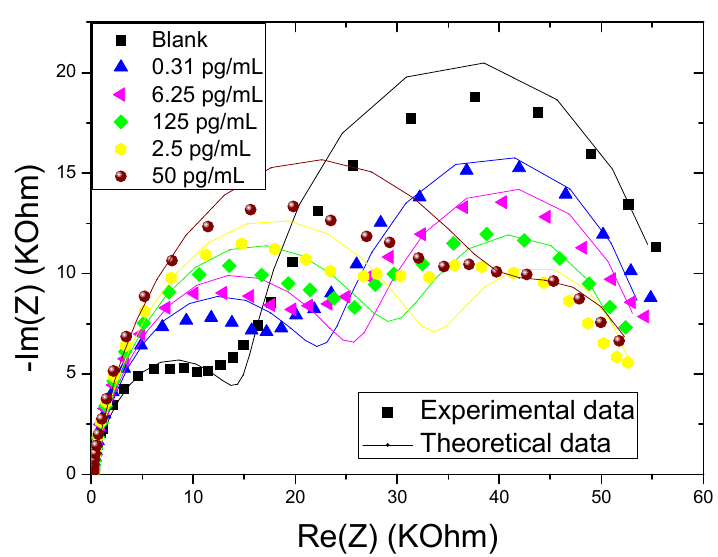
Figure 2. Experimental and theoretical EIS of CS ‐ MIPs/CMA/Au in 5 mM [Fe(CN)6] 3 − /4 − initial po ‐